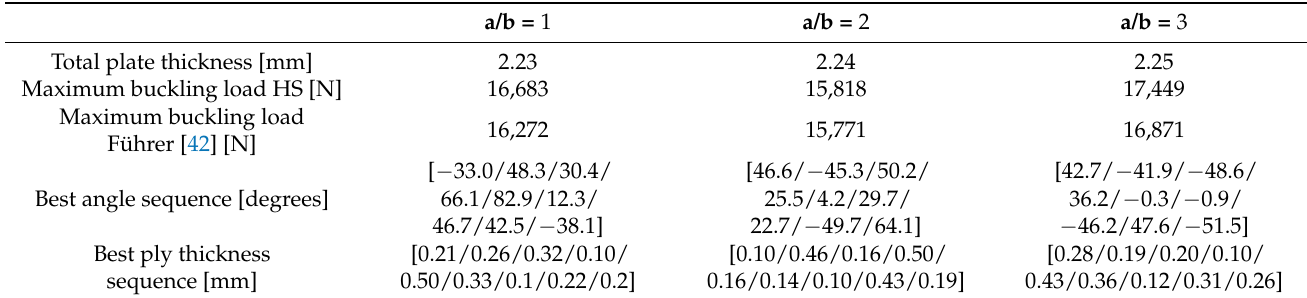
Table 4. The results of the harmony search optimization for the CFRP plates with circular cut-outs.